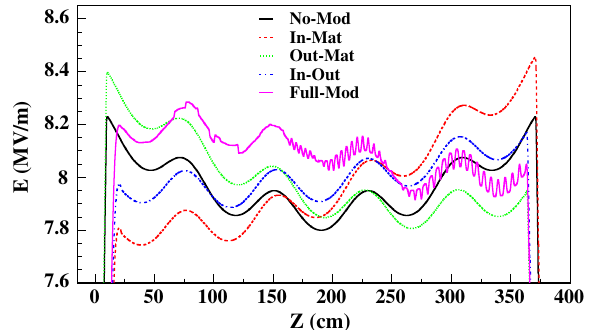
FIG. 17. Intervane electric field along the RFQ for different components of the modulation.